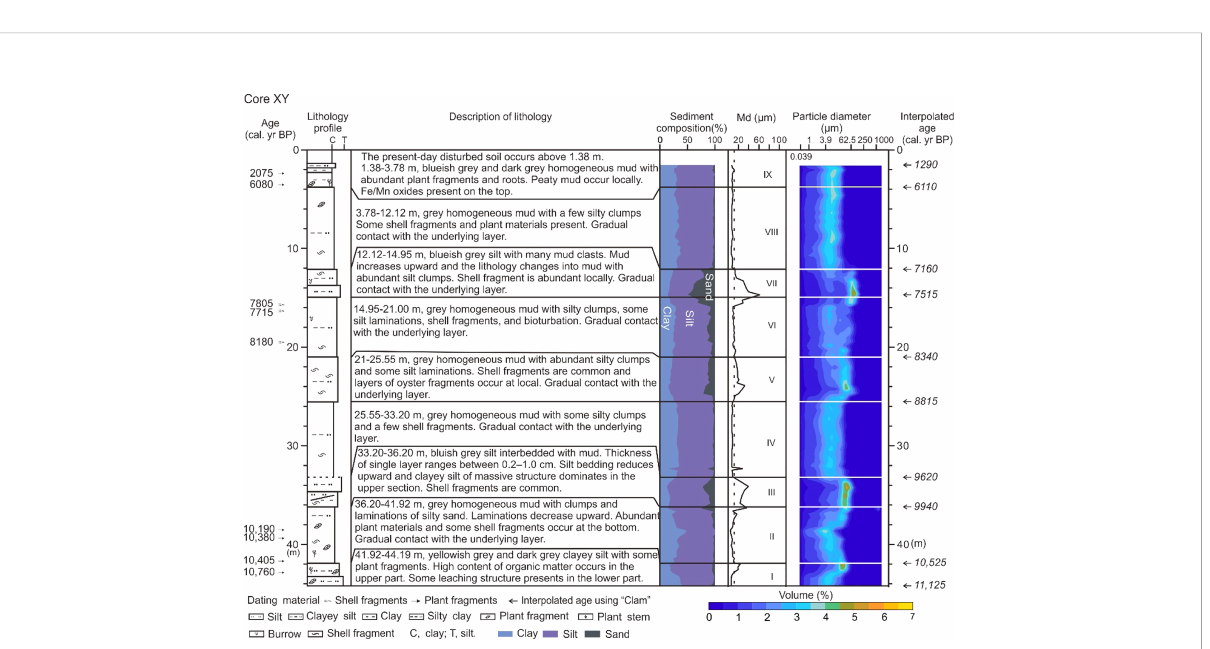
FIGURE 3 Sedimentary pro fi le of core XY, including lithology description, calibrated radiocarbon ages, grain size composition, median grain size, and the distribution of volume frequency of grain size. Interpolated ages by “ Clam ” at the boundaries of each unit are also indicated on the right side.